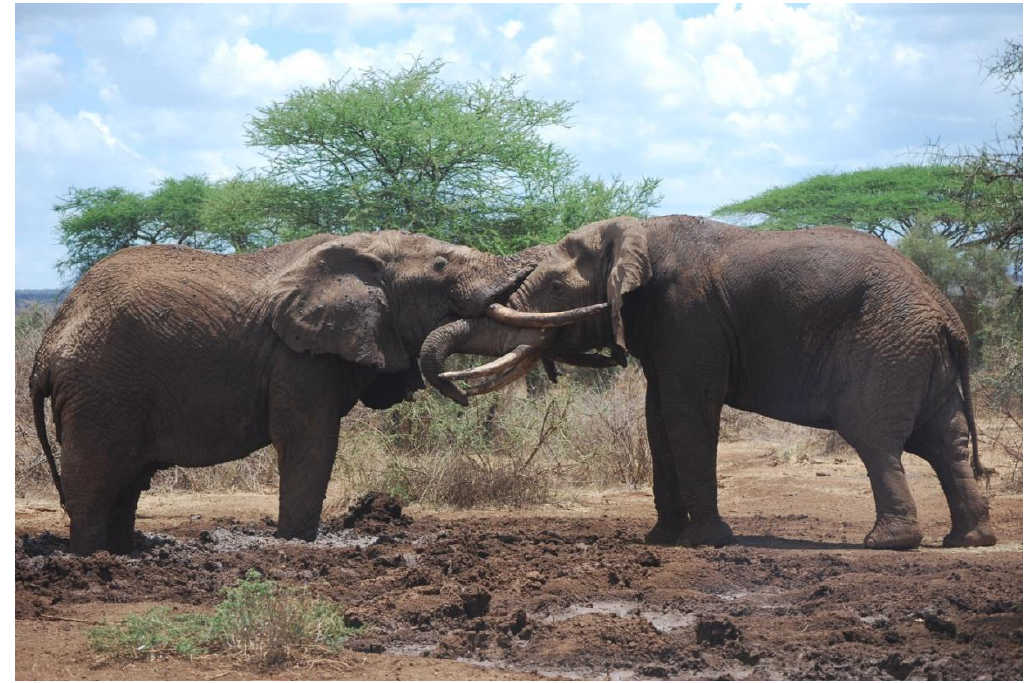
Figure 1 . Two 30+ year old males engaging in wrestle play in a mud